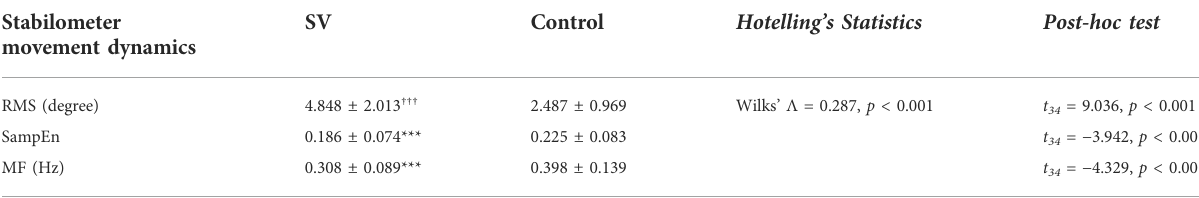
TABLE 1 The contrast angular fl uctuation of stabilometer movement dynamics between the stroboscopic vision and control conditions. Stabilometer movement dynamics